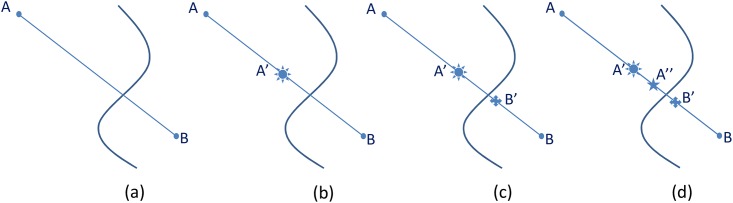
Binary subdivision.